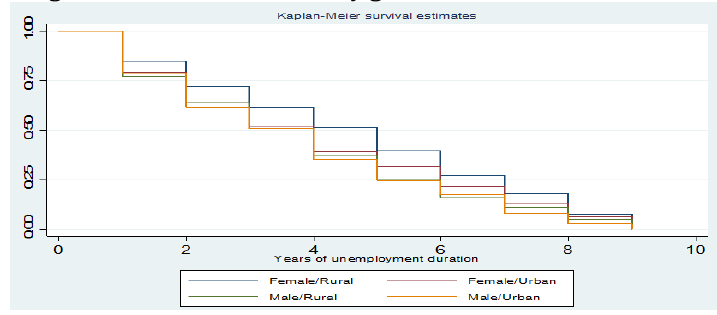
Source: TLMPS 2014 and authors’ calculation